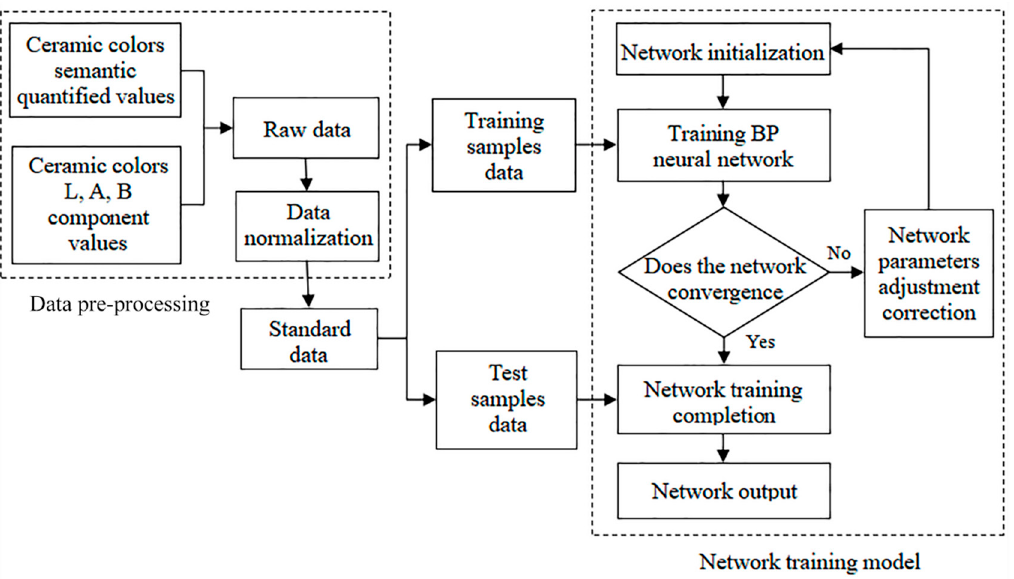
Figure 6. Structure of the semantic mapping model of ceramic color based on BP neural network.